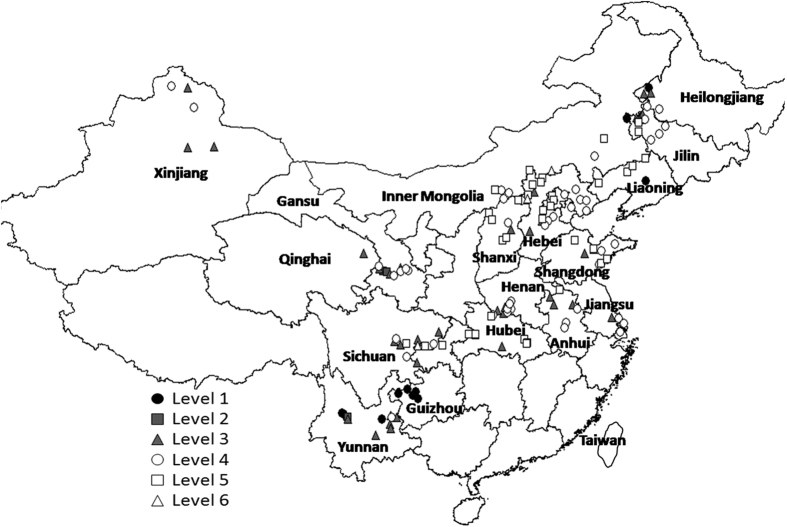
Map of classification of soil available nitrogen (AN) in food legumes growing areas, Greater China.Created by DIVA_GIS (v7.5) software. Hijmans, R.J., Guarino, L., Mathur P. DIVA-GIS. Version. 7.5. http://www.diva-gis.org/ (2012) Data of access: 05/07/2015.